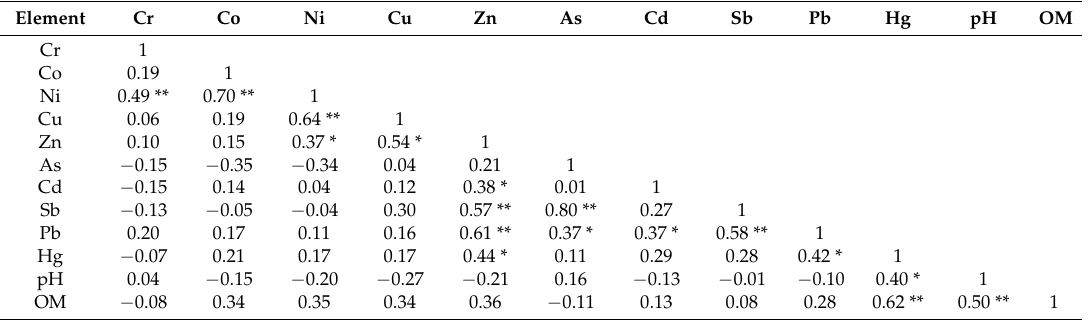
Table 5. Correlation coefficient for metal(loid)s, pH, OM in street dust of Hezhang city ( n = 30). Element